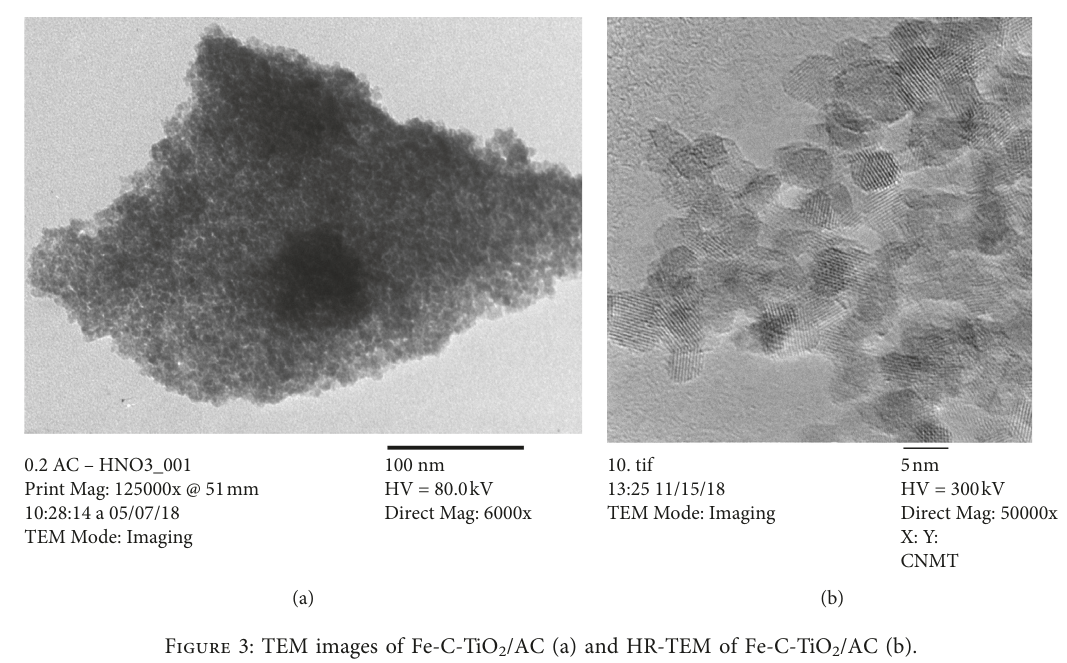
Figure 3: TEM images of Fe-C-TiO 2 /AC (a) and HR-TEM of Fe-C-TiO 2 /AC (b).